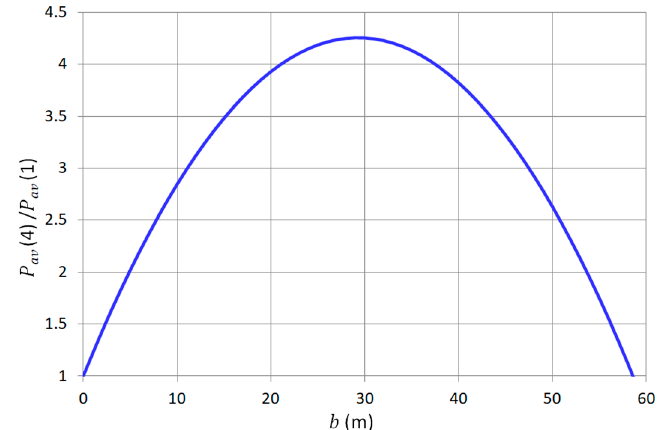
Figure 12. Average tidal power generation as a function of the water height “ b ”: the y-axis shows the value of P av obtained from (4) normalized with respect to the value of P av obtained from